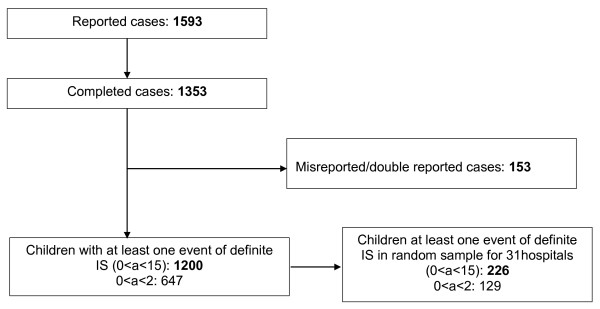
Study population.